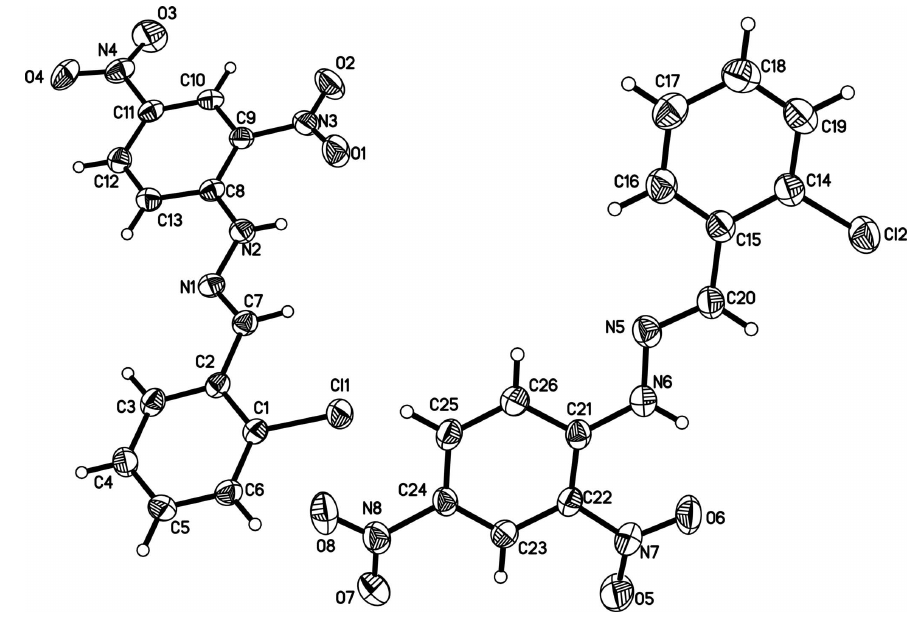
Figure 1 The molecular structure of (I), with displacement ellipsoids drawn at the 50% probability level.